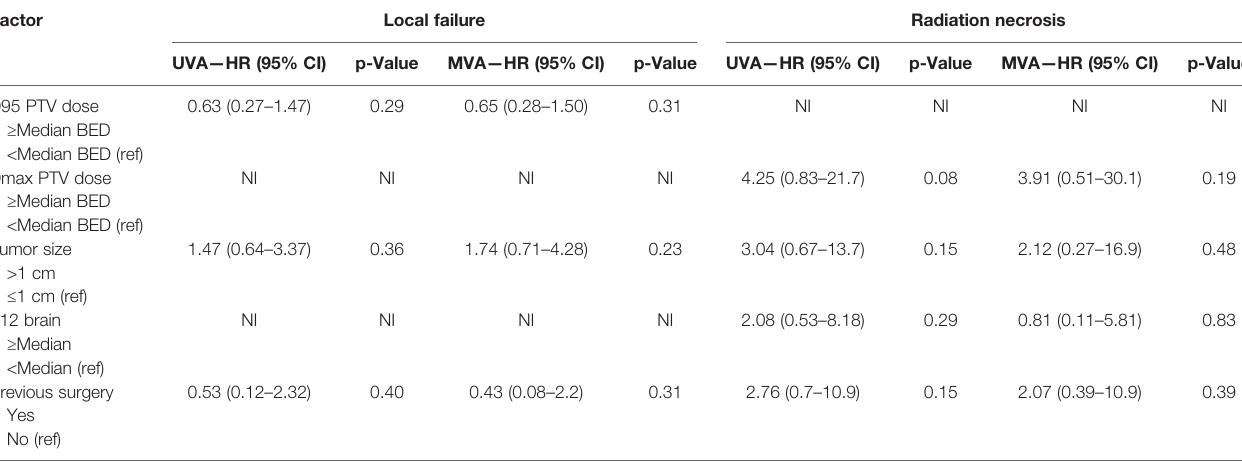
TABLE 3 | Univariable and multivariable analyses for local failure and radiation necrosis.